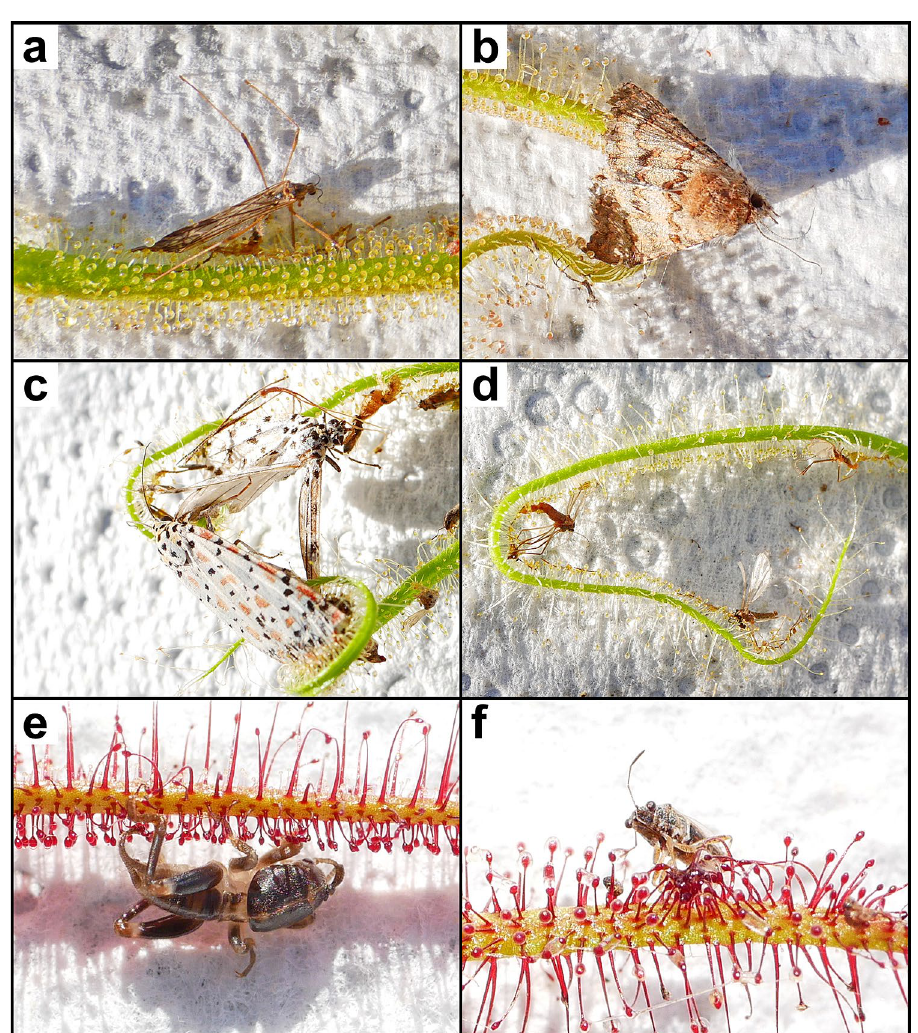
Figure 2. Examples of captured arthropod prey detected and correctly identified by DNA metabarcoding in three Western Australian species of Drosera sect. Arachnopus . The lowest taxonomic level determined by metabarcoding and the corresponding family, order and BOLD Barcode Index Number (BIN) is indicated. ( a ) Symplecta sp. (Limoniidae, Diptera, BOLD:AAF8963) captured by D. finlaysoniana (Sample 5). ( b ) Praxis marmarinopa (Erebidae, Lepidoptera, BOLD:AAC9474) captured by D. finlaysoniana (Sample 9). ( c ) 2 individuals of Utetheisa lotrix (Erebidae, Lepidoptera, BOLD:AAA4528) captured by D. margaritacea